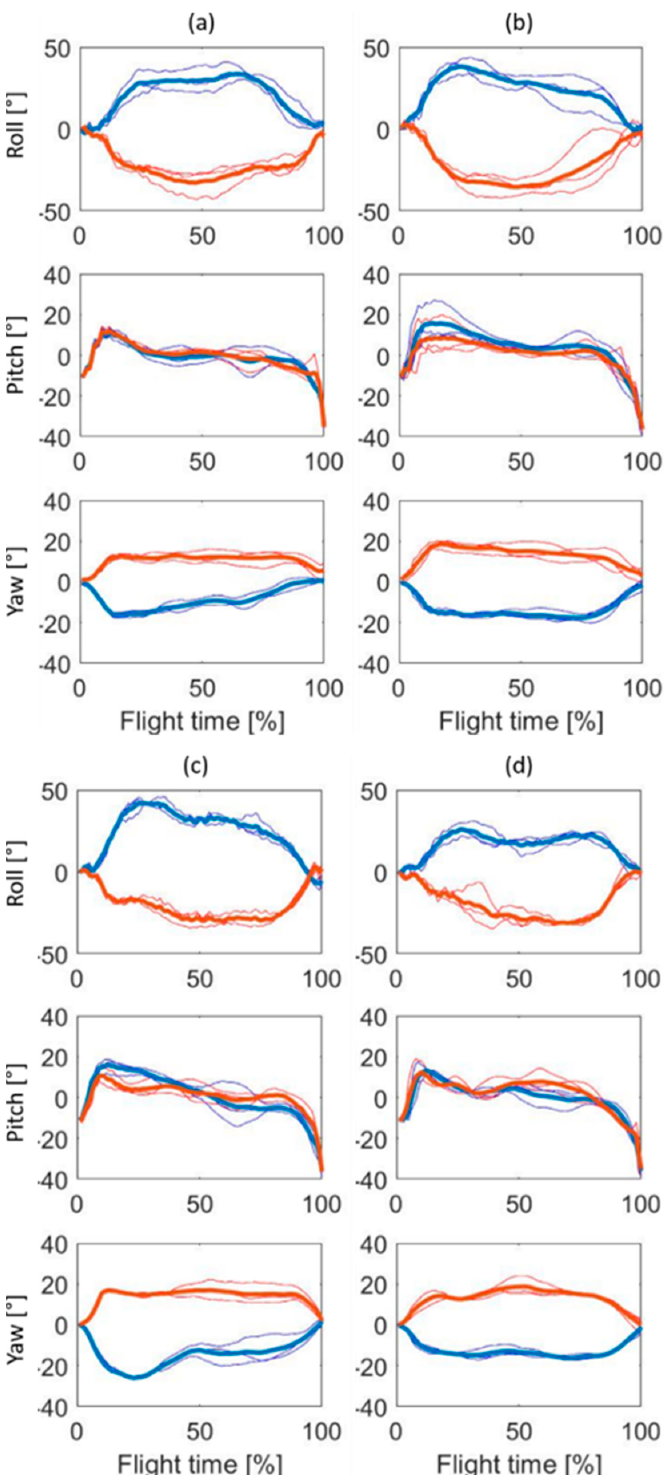
Figure 4. Normalized ski angular movements of roll, pitch, and yaw for three jumps of the four athletes collected in Ramsau-am-Dachstein ( a – d ). The blue line represents the left ski, the red line represents the right ski. The thick lines represent the average of the three normalized trajectories of each athlete, while the thin lines show the trajectory of a single